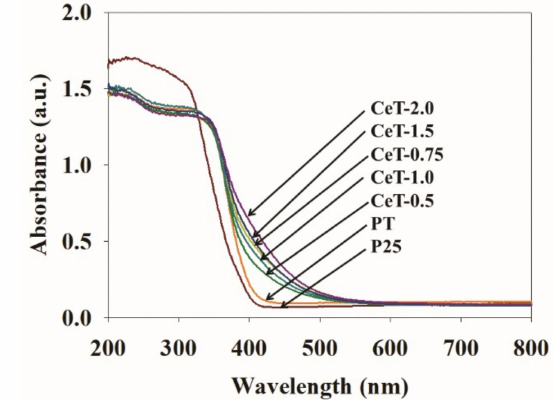
Figure 4. UV-vis di ff use reflectance spectroscopy (UV-vis DRS) of Degussa P25 TiO 2 (P25), pure TiO 2 (PT), and Ce-doped TiO 2 catalysts with di ff erent Ce contents (CeT-0.5, 0.75, 1.0, 1.5, and 2.0).